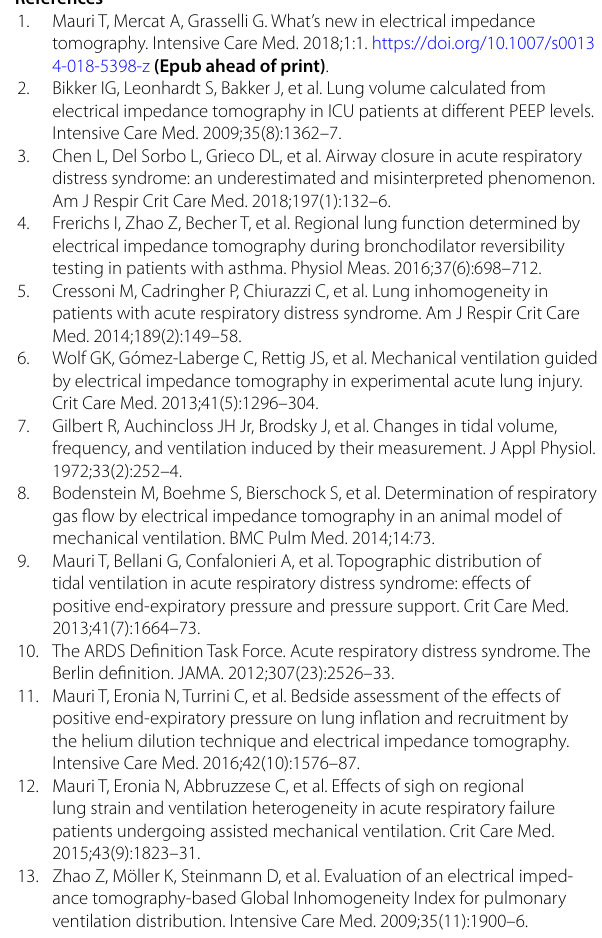
Additional file 1. Regressions and Bland–Altman plots reporting specific results from each step of both studies (six conditions, 12 linear regressions and 12 Bland–Altman